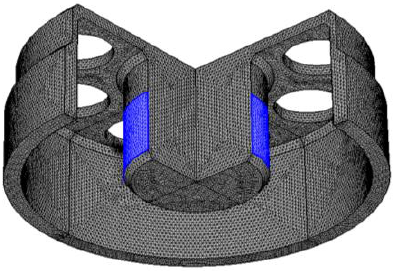
Figure 4. Grid model of the cylindrical resonator .